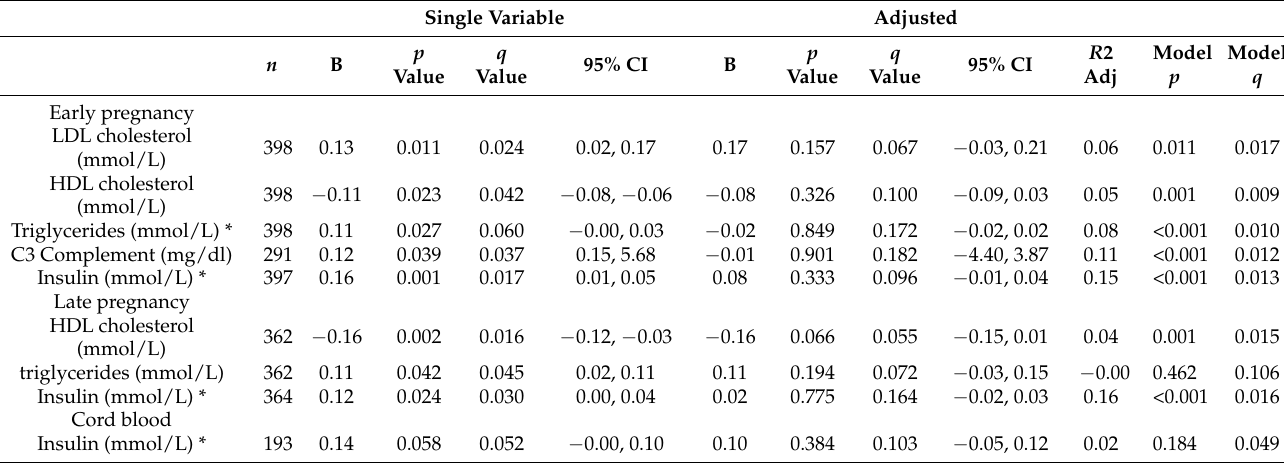
Table 4 includes the results of multiple linear regression models on the association between early E-DII TM score and cardiometabolic markers. There was no potential inter- action effect noted for either infant sex or BMI on these relationships (all p values > 0.05), except for a potential relationship between infant sex and E-DII on insulin in late pregnancy, p = 0.049, q = 0.124. When the data were stratified by infant sex, however, no significant associations were seen for E-DII in adjusted linear regression (all p > 0.05). Table 4. Multiple linear regression models for E-DII ® and cardiometabolic and inflammatory marker. Single Variable